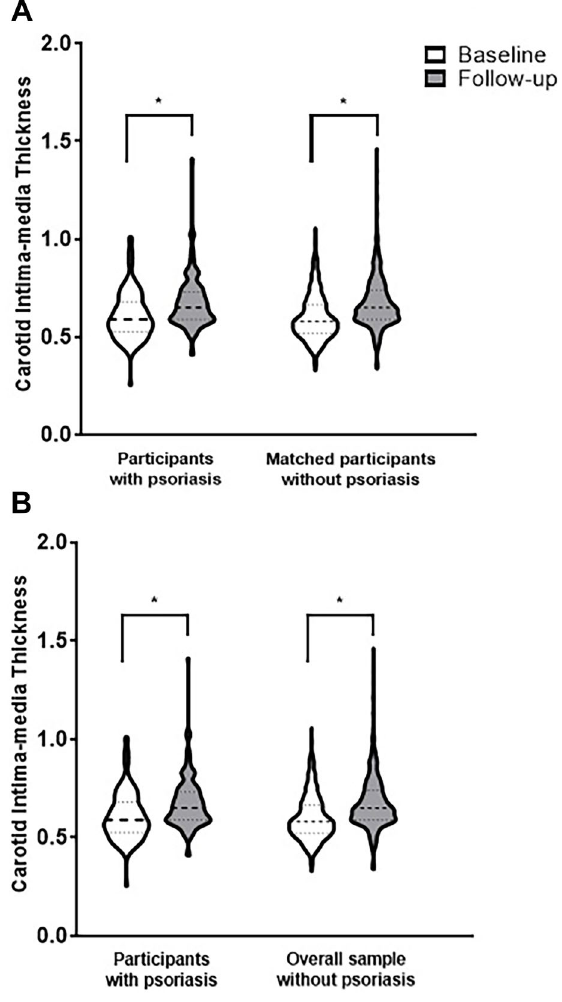
Figure 2. Violin plot of carotid intima-media thickness (in mm) at baseline and after the 8-year follow-up, according to diagnosis of psoriasis. *P o 0.001 (Wilcoxon